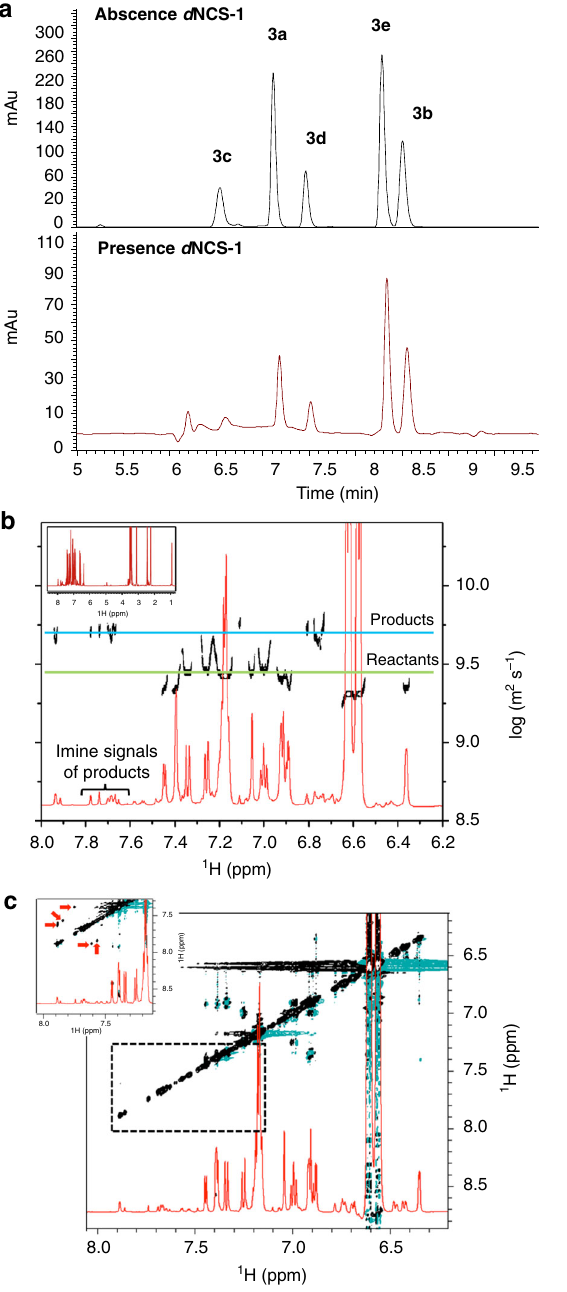
Fig. 4 HPLC-MS and NMR studies of the full dynamic combinatorial library. a DCL chromatograms after 5 h in the absence and in the presence of d NCS-1. Conditions: aldehyde 1 (1.2 µ L, 50 mM), 2a – 2e (3.6 µ L, 50 mM), catalyst (1 µ L, 12 M), d NCS-1: 1 [1:1], Tris buffer (20 mM, pH 7.4), 1 mM CaCl 2 , 0.5 M NaCl, 1 mM DTT, T = 4 °C, 2% DMSO. DCC experiments were carried out in triplicate. b 1D- 1 H NMR spectrum (red) of the mixture and DOSY experiment (black) of the DCL in the presence of d NCS-1 (281 K, 600 MHz). c Tr-NOESY spectrum of the DCL mixture in the presence of d NCS-1 (mixing time 200 ms, 281 K, 600 MHz). Ampli fi cation of the region δ 7.2 – 8.0 ppm. The negative transferred NOE cross-peaks corresponding to intramolecular NOEs of the products while bound to the protein are highlighted with red solid arrows. d 1 H-NMR spectrum of the sample with acylhydrazide 2b and acylhydrazone 3c in the presence of d NCS-1 at different reaction times and up to 15 days (281 K, 600 MHz). The new signals that reveal the formation of 3b (aromatic region) and 2c (aliphatic region) are marked with stars. 1 H-STD-NMR (blue) and off-resonance (red) NMR spectra of the mixture 2b + 3c + d NCS-1 (281 K, 600 MHz) after 15